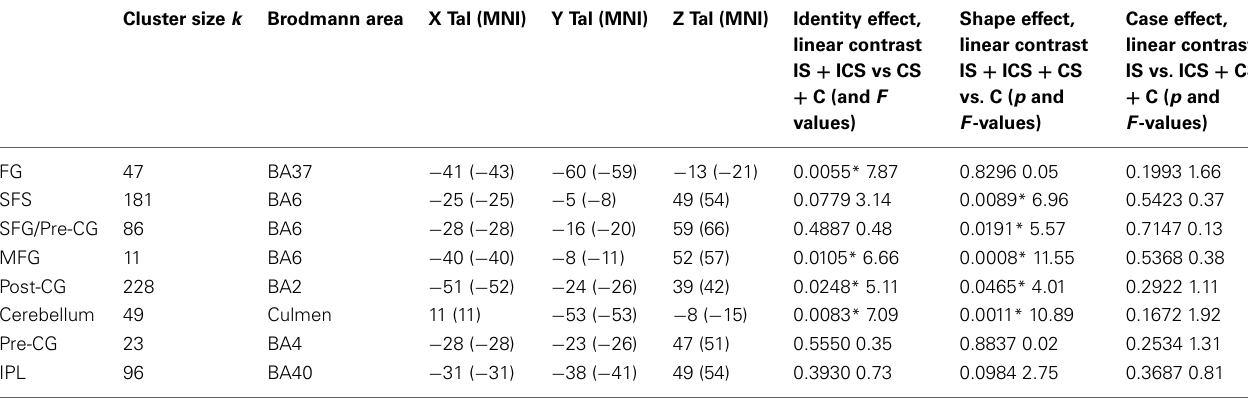
Table 2 | Results of Analyses 1 and